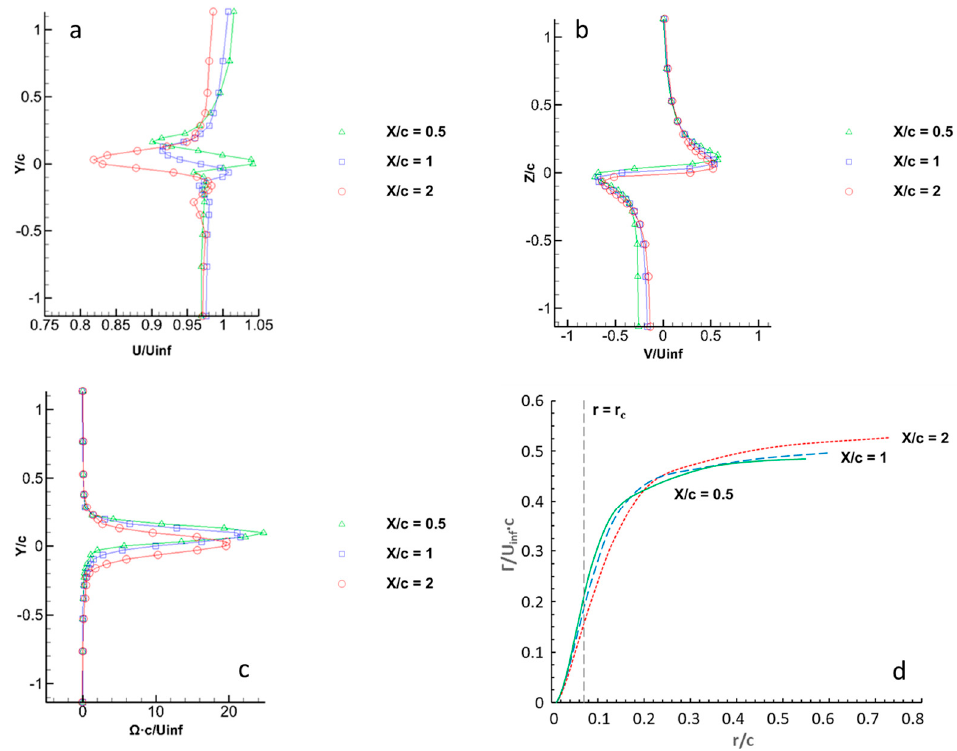
Figure 14. Time-averaged axial ( a ) and normal velocity ( b ), vorticity ( c ), and circulation ( d ), without winglet.